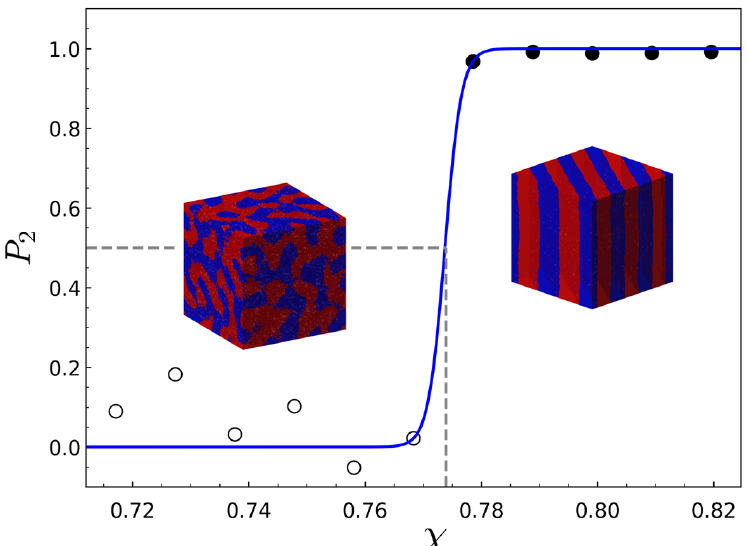
Figure 2. The order parameter versus the interaction parameter for the C-TBC with { M = 24, N = 4 } . The open circles and filled circles represent the points where the disordered and the ordered phases are stable, respectively, and the blue solid line is fit to a three-parameter sigmoidal function. The inset images show the two example structures simulated at the disordered and ordered region. Table 2. The chain architectures of triblock copolymers simulated in this study and the list of the χ values at ODT, χ and the domain spacing, L , for these triblock copolymers in molten state. ODT Architecure